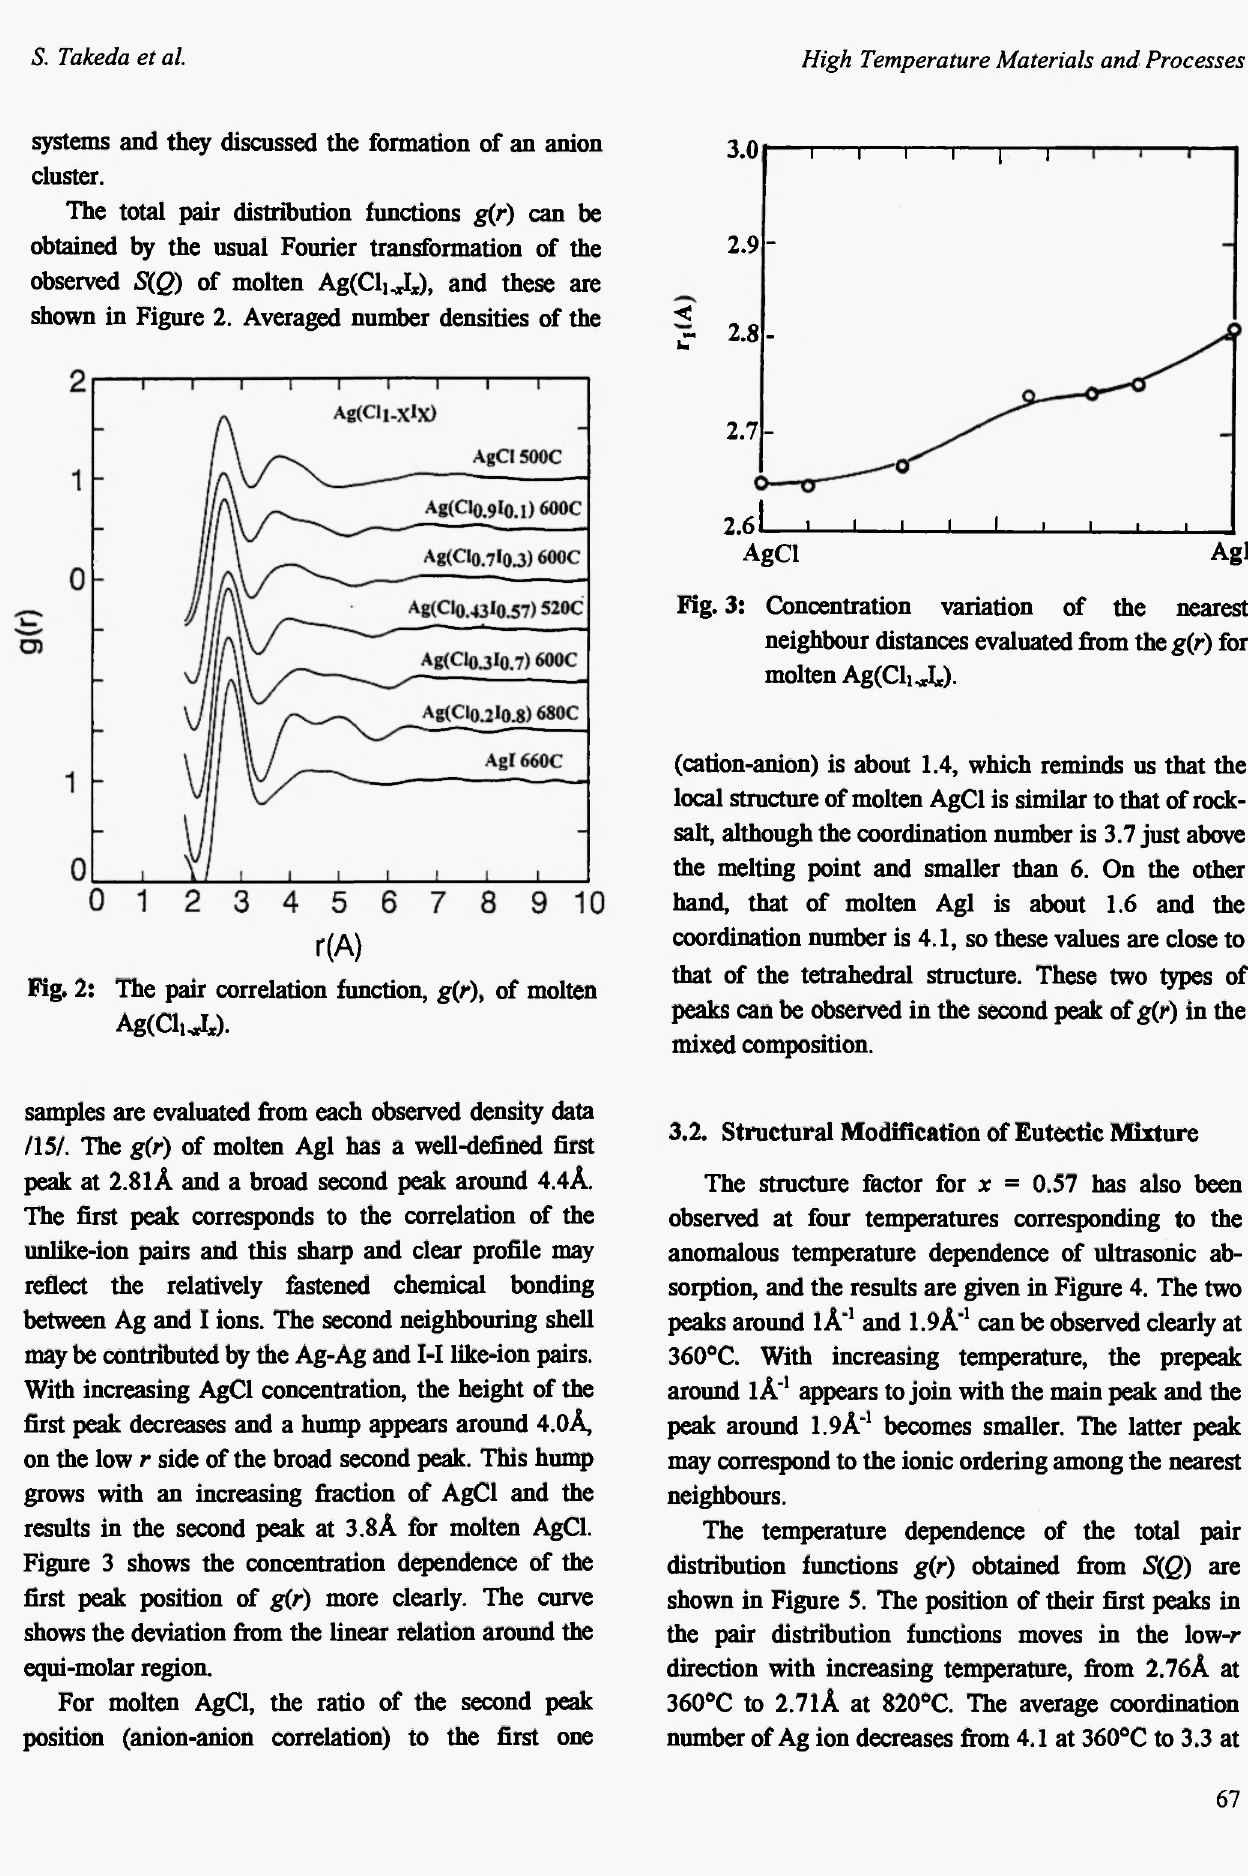
Fig. 2: The pair correlation function, g(r), of molten Ag(CW ). x